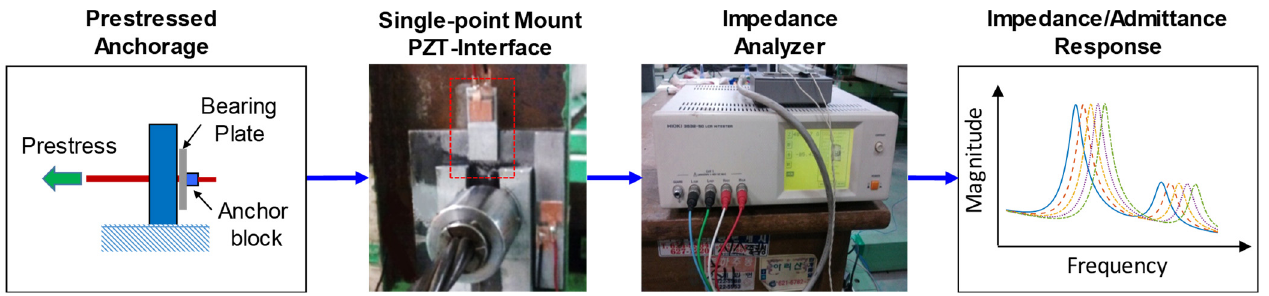
Figure 3. Overall experimental methodology.